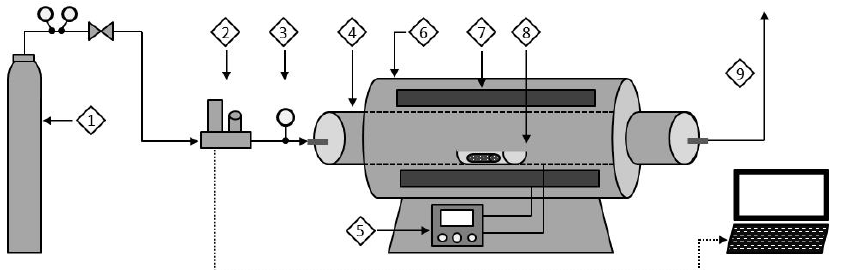
Figure 1. Apparatus for conduction of thermolytic processes on supported ionic liquid membranes: (1) gas cylinder (Ar); (2) mass flow controller; (3) pressure gauge; (4) refractory tube; (5) PID temperature controller; (6) tubular furnace; (7) heating zone; (8) ceramic capsule; (9) vent.